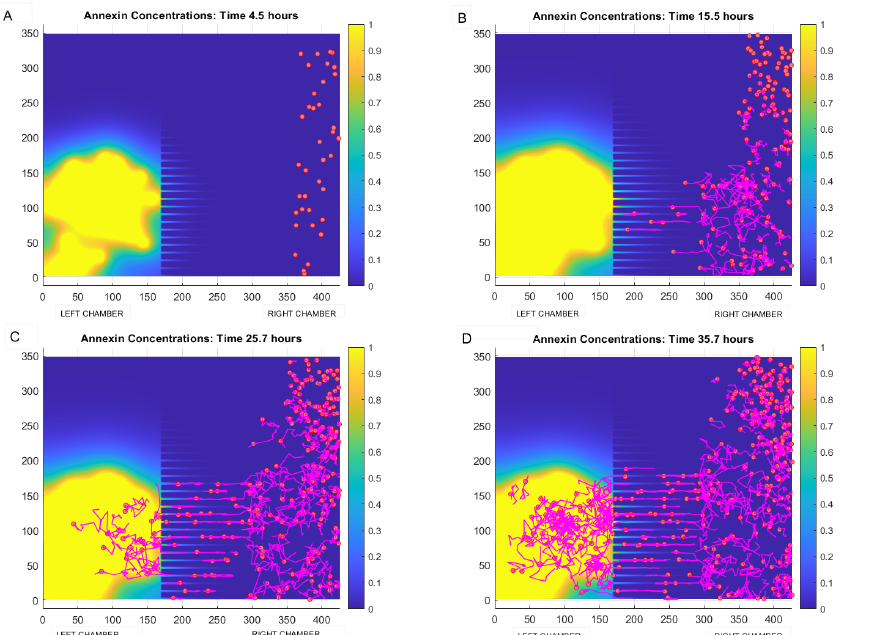
Figure 5. Evolution in time of annexin secreted by chemical sources (TCs) and of leukocyte dynamics computed by the model (3)–(5). Panel ( A ): situation at time of about 4 h with TCs (depicted as yellow balls) located in the right chamber, and the presence of some leukocytes (depicted as magenta balls) migrated passively from another location of the chip towards the right chamber. Panel ( B ): formation of chemical field (in yellow) after 15 h and migration of leukocytes by crossing the microchannels and following the chemical gradient in the left chamber. Panel ( C ): situation after 25 h, with some leukocytes migrated in the left chamber. Panel ( D ): configuration after 35 h, with leukocytes distributed in the left and right chamber. Both in Panel ( C , D ) it can be observed that leukocytes in the left chamber accumulate in the zone with higher concentration of